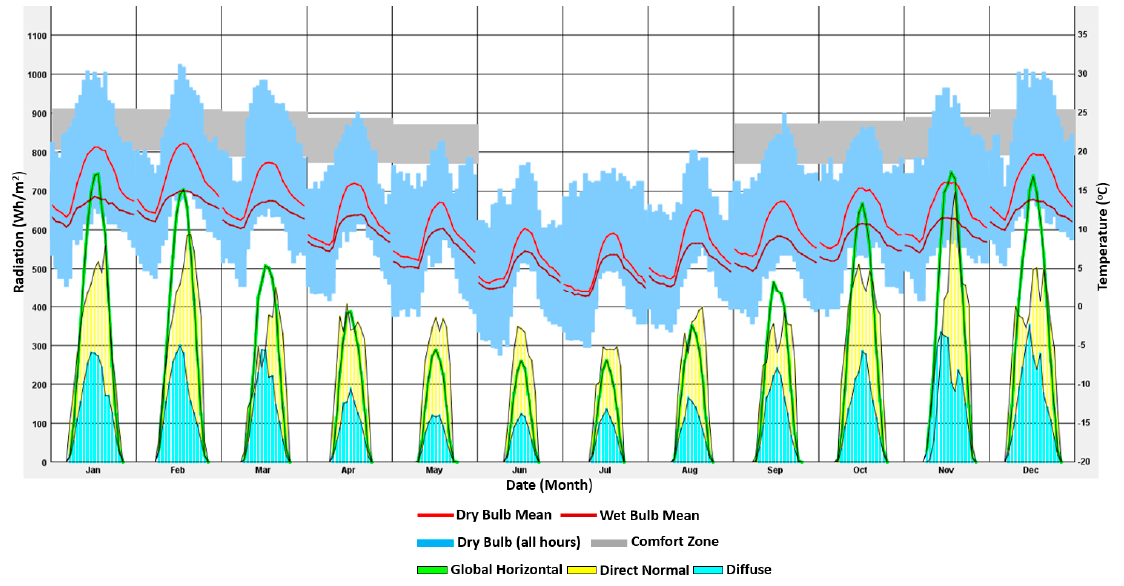
Figure A1. Annual weather data for Christchurch, Canterbury, New Zealand (Adapted from Climate Consultant 6.0).